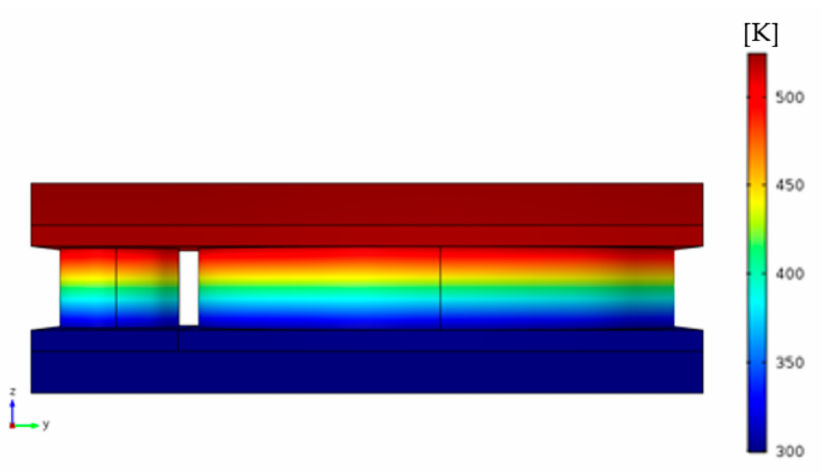
Figure 10. Temperature field [K] across the